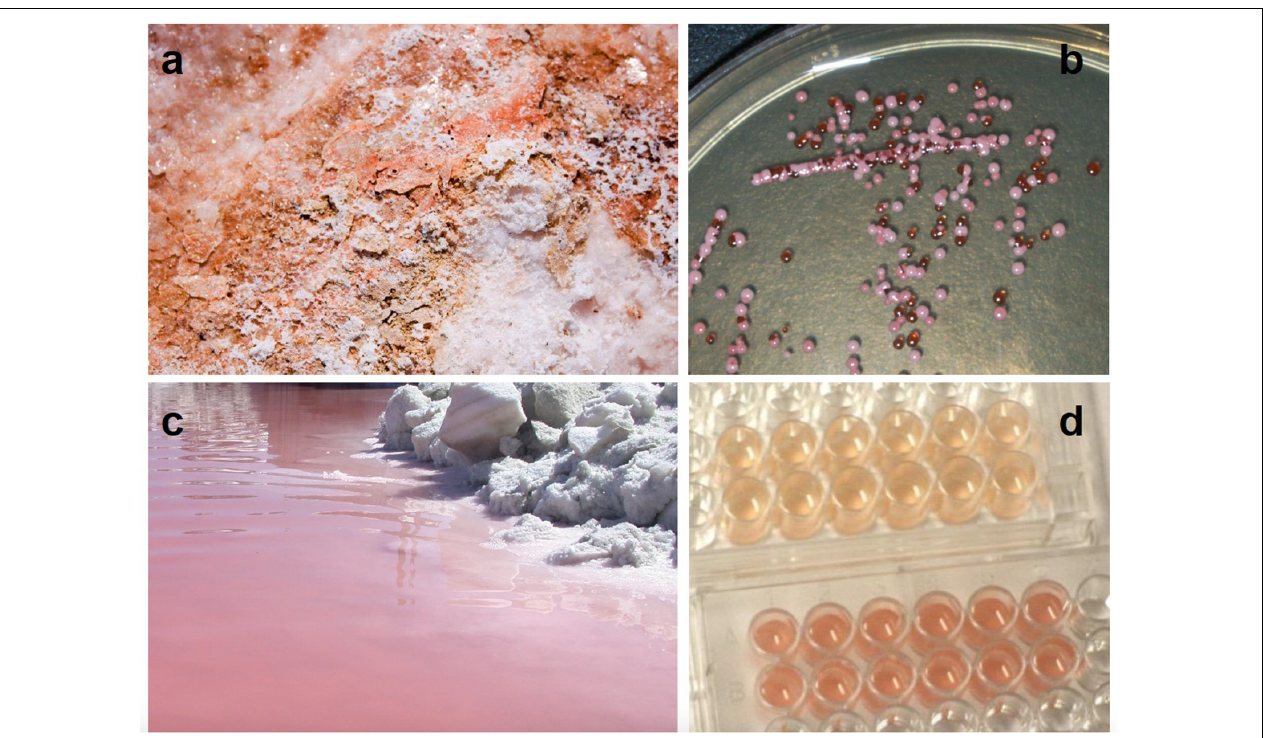
FIGURE 1 | Carotenoid pigmentation in Great Salt Lake (Utah, United States) halophilic archaea (a) embedded in a shoreline salt crust, (b) growing in colonies on salt agar, and (c) coloring the north arm water pink. (d) A Great Salt Lake Halorubrum species was grown in the absence (top) and presence (bottom) of full spectrum light, demonstrating the impact of light on carotenogenesis (Baxter et al.,